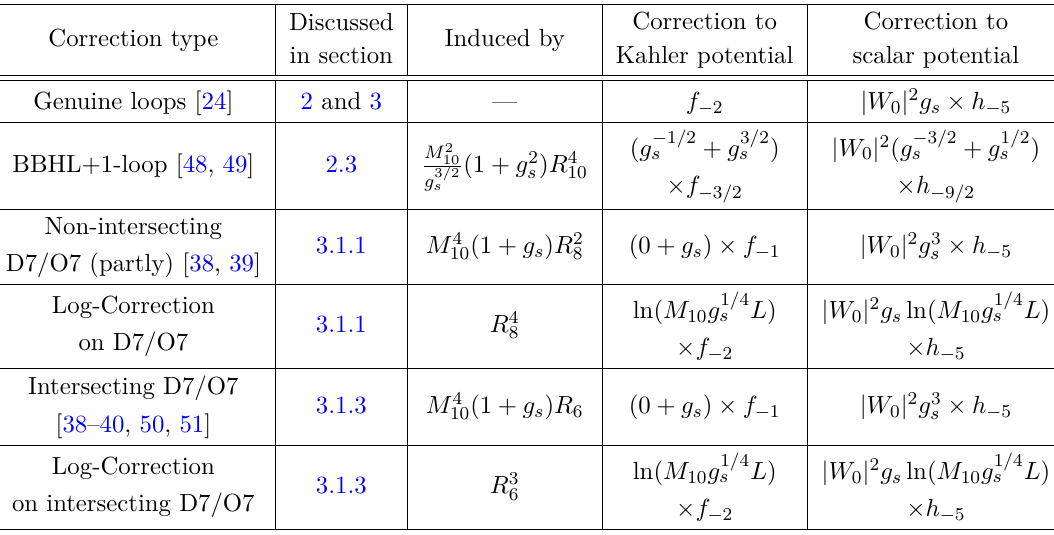
Table 1 . Some of the key corrections discussed in the paper and their effect on the Kahler and scalar potential. The functions f − λ , h − λ are homogeneous of degree − λ in 4-cycles and L is the typical length scale of the internal